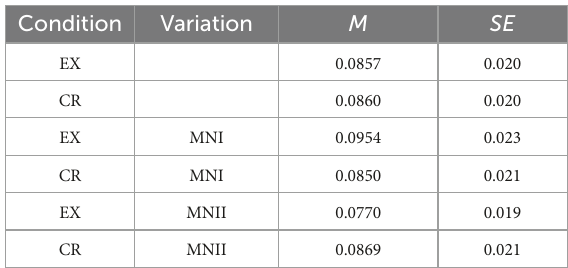
TABLE 10 Esteemed marginal means ( M ) and standard error ( SE ) for RR for EX (experimental) and CR (control) conditions in Experiment 2 and EX and CR conditions in MNI and MNII (with only one of the two rebus images, respectively the first and the last) variations of Experiment